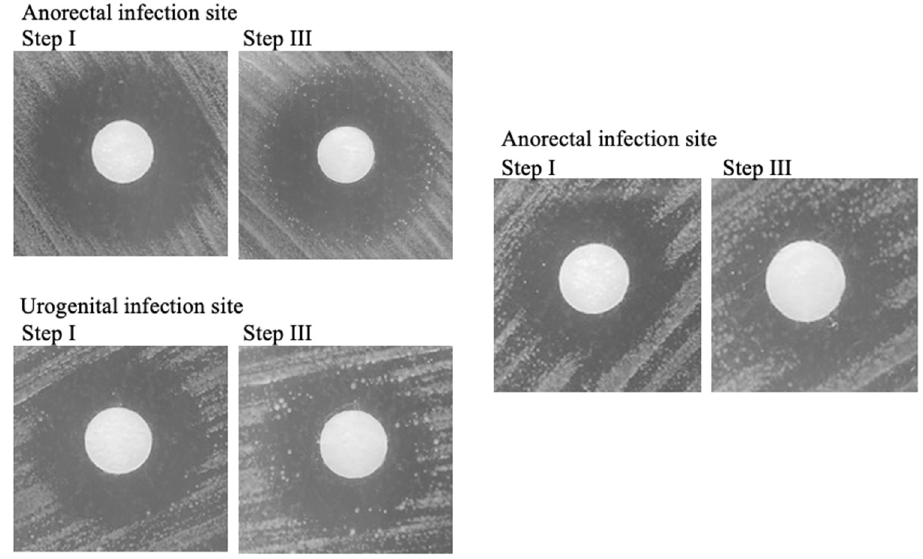
Figure 4. Detection of tolerance to CRO in three different clinical isolates of N. gonorrhoeae using a TD test. Step I: after overnight incubation with a 0.008 µg CRO discs. Step III: results after nutrient replenishment; 6 mm discs.